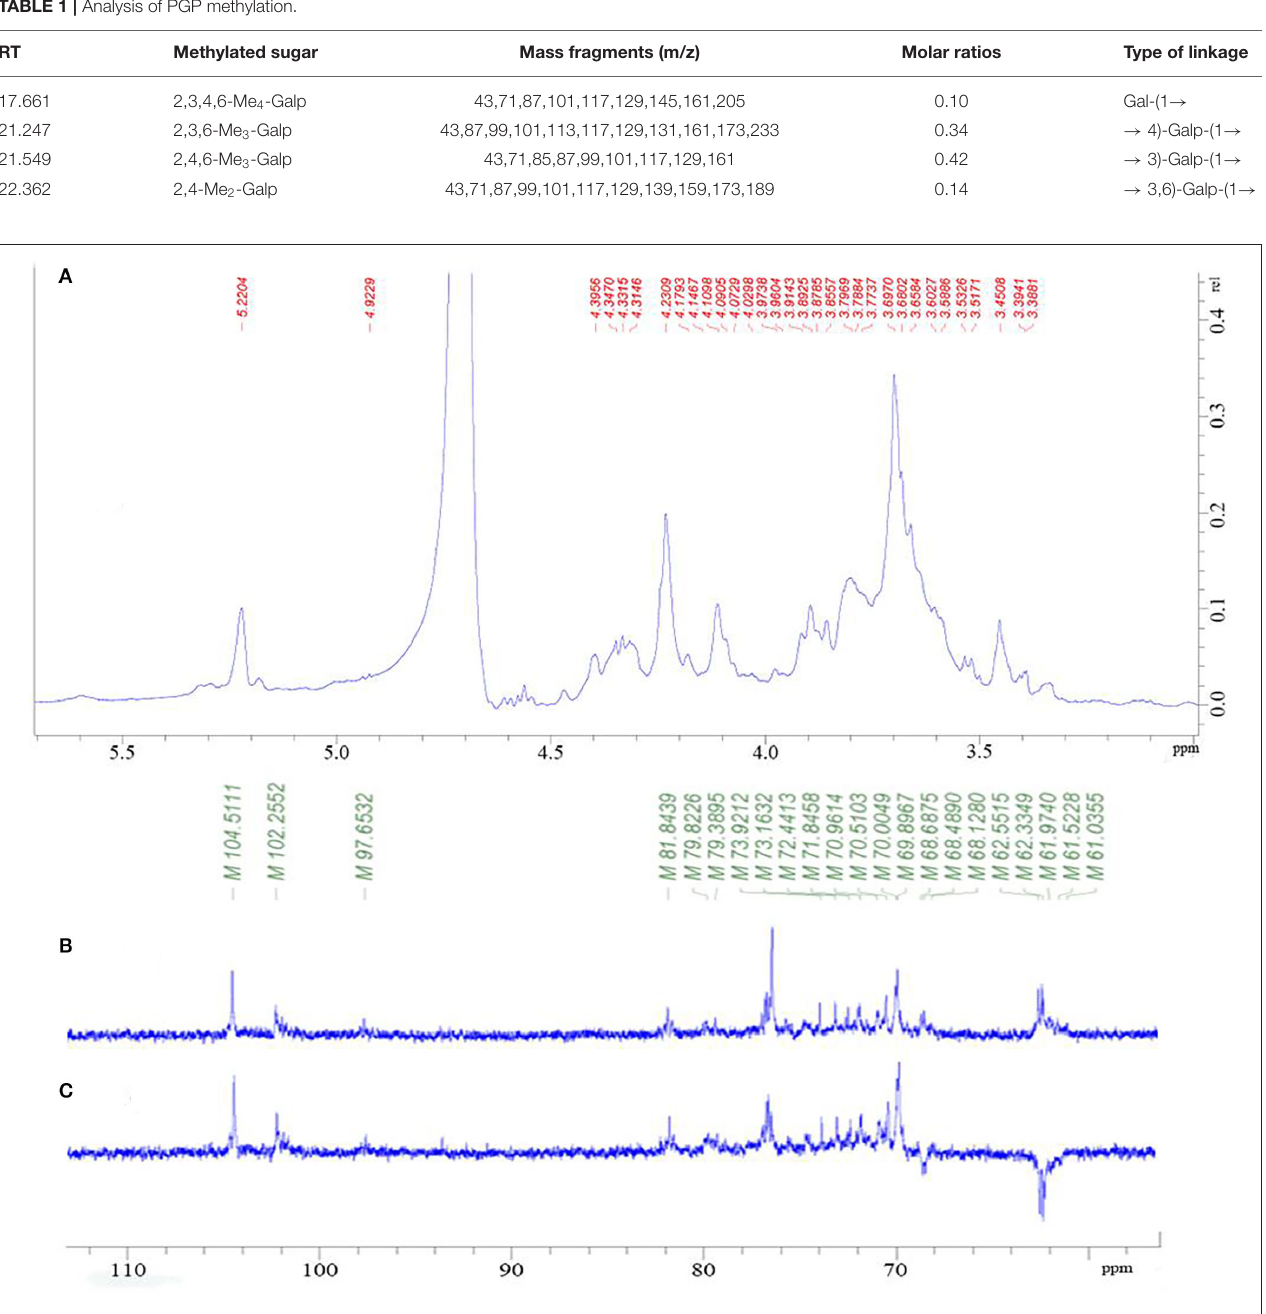
branched chains may be degraded by citric acid. The proportion of 1 → 3 Gal and 1 → 4 Gal was similar, indicating that there was a common disaccharide unit in red algae. → 3,6)-Galp- (1 → indicated that there were substituted sulfate and galactose residues at